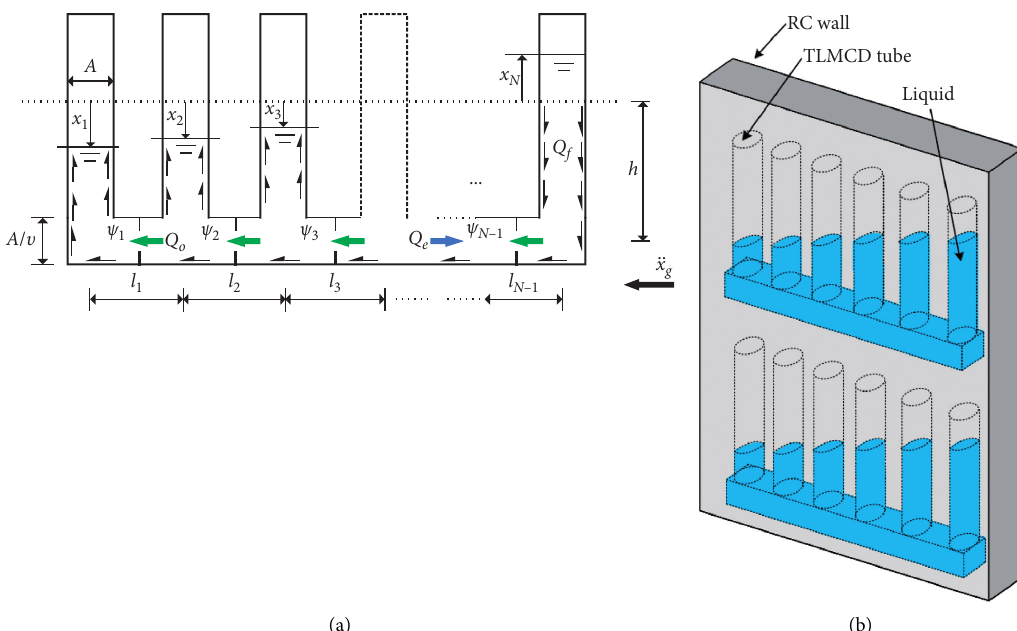
Figure 1: Schematic of (a) TLMCD [13] and (b) TLWD system consisting of a shear wall with embedded